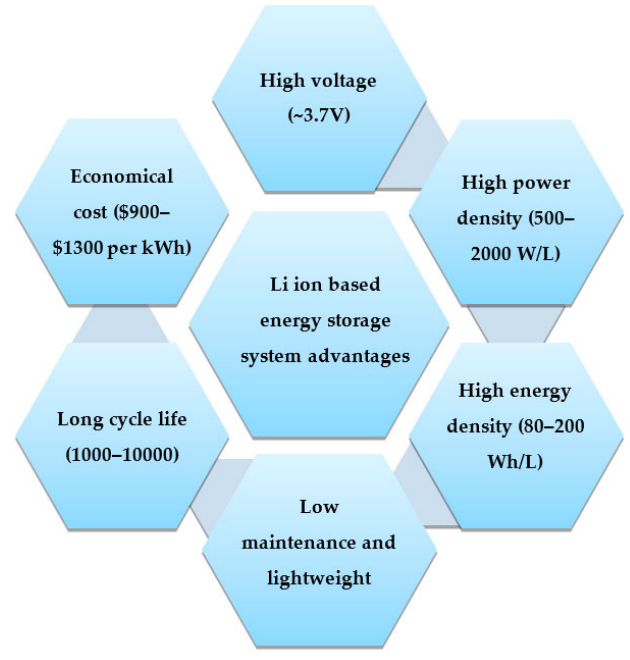
Figure 2. Advantages of Li ion-based energy storage system [23–25].